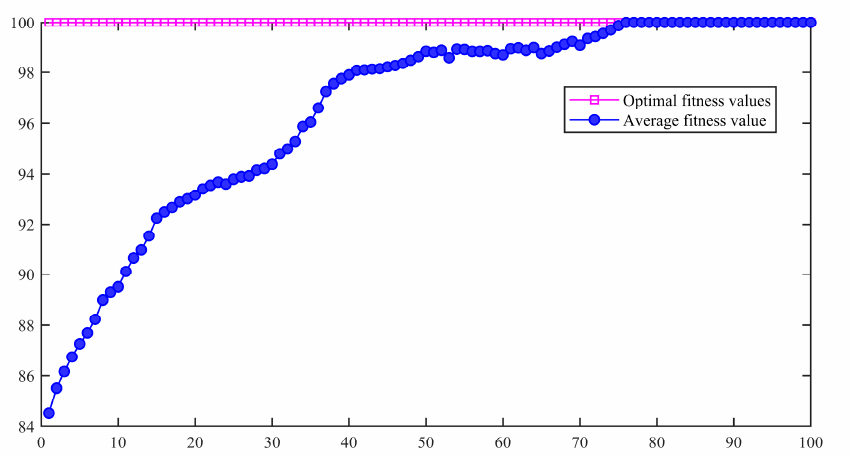
Figure 9. The optimal fitness curve of the improved bat algorithm.